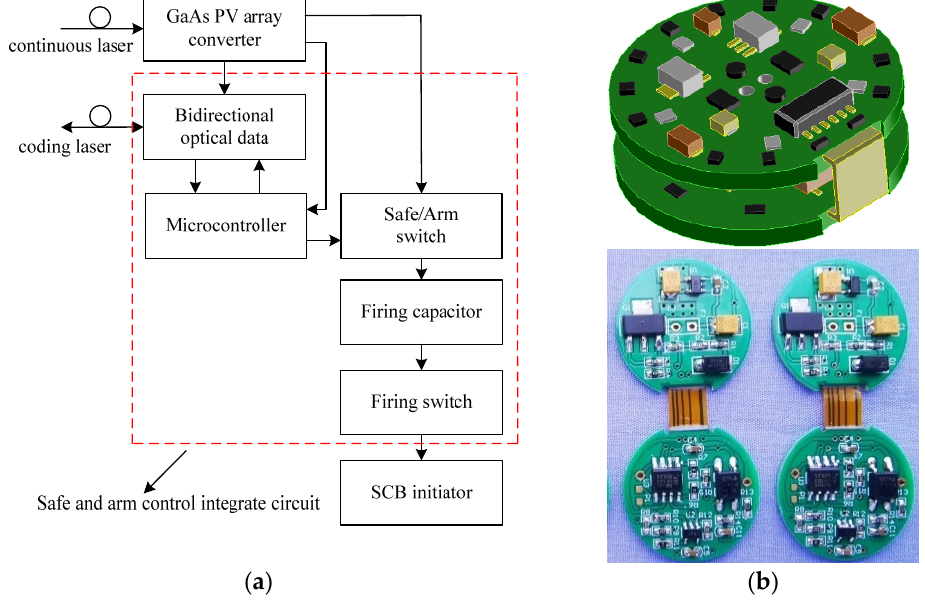
Figure 12. Safe-and-arm control-integrated circuit. ( a ) Module composition. ( b ) Integrated circuit prototype.